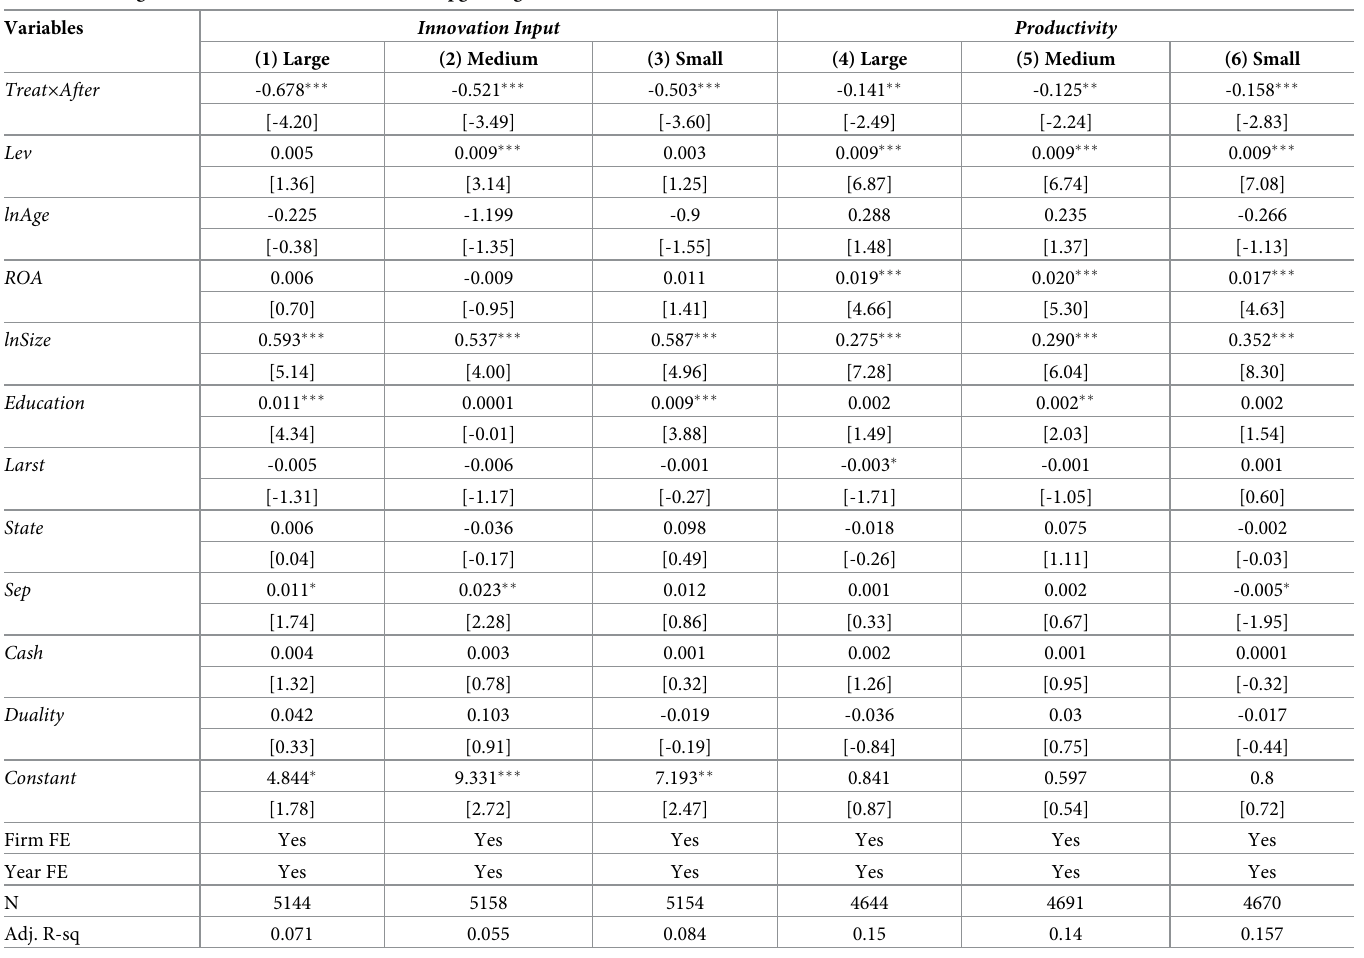
Table 6. Heterogeneous effect of EPTL2016 on firm upgrading with different